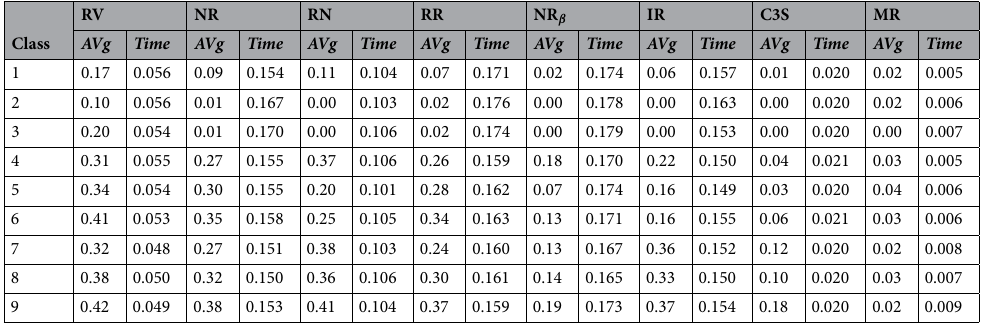
Table 11. AVg and Time variations according to classes for all